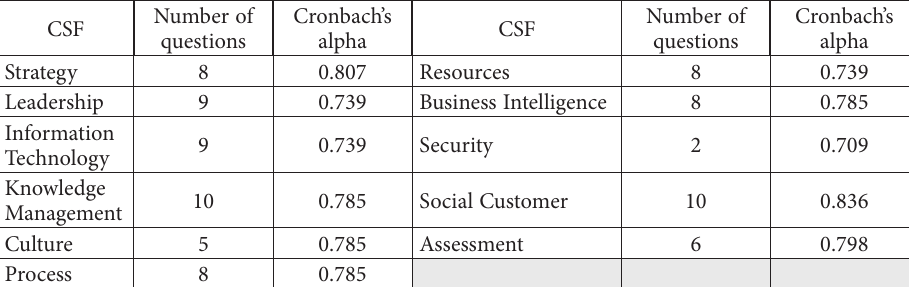
Table 5. Frequency of questions and results of questionnaire reliability Number of Cronbach’s CSF questions alpha